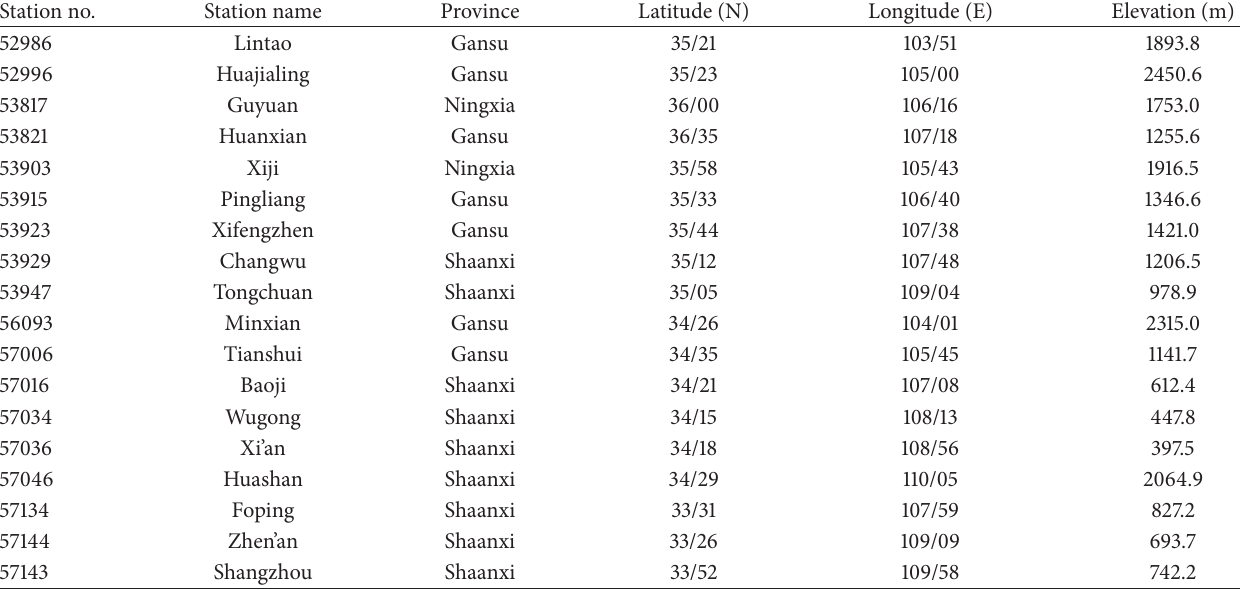
Table 1: Locations of the 18 rain gauging stations that provided the precipitation data examined in this study. Station no.